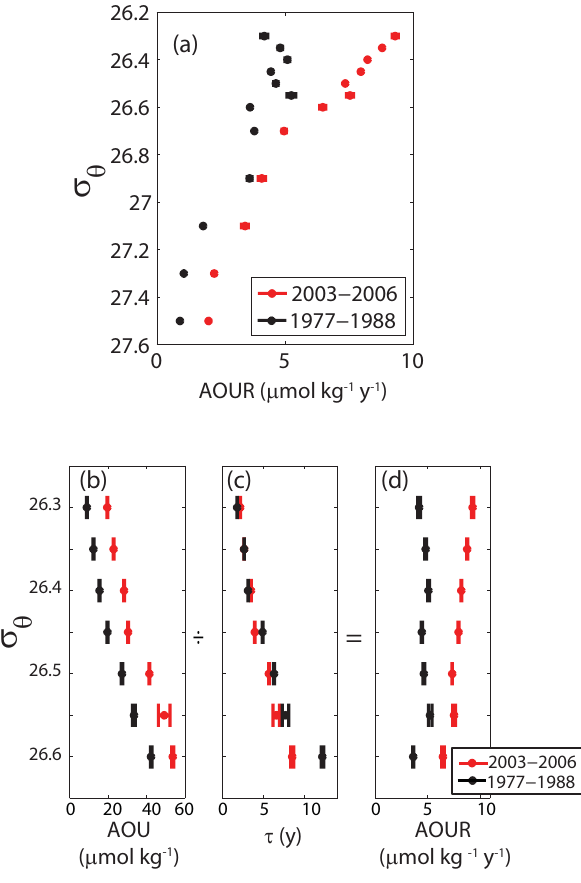
Fig. 7. Comparison of estimates from 2003-2006 (red) and 1977– 1988 (black) of (a) AOUR averaged over isopycnal surfaces in the upper 1200m of the water column and of (b) AOU, (c) water age ( τ) and (d) AOUR over isopycnal surfaces from 26.3 to 26.6kgm − 3 (upper 500m only). Note the difference in AOUR between the two time-periods, especially in the upper 500m. This difference is due to changes in AOU, not to changes in τ .